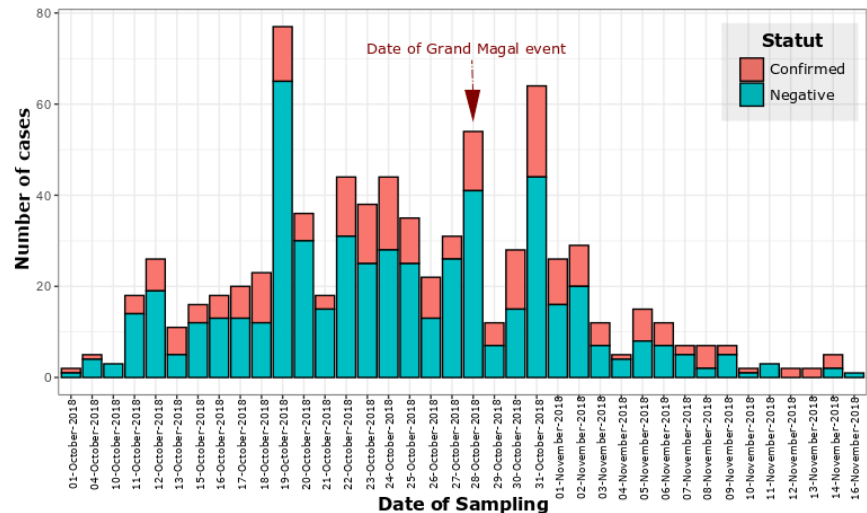
Figure 4. Epidemic curve describing the distribution of negatives and confirmed dengue cases according to the day of sampling. The date of the religious event (28 October 2018) is marked by the red arrow; this date corresponds to week 44 (Figure S1).